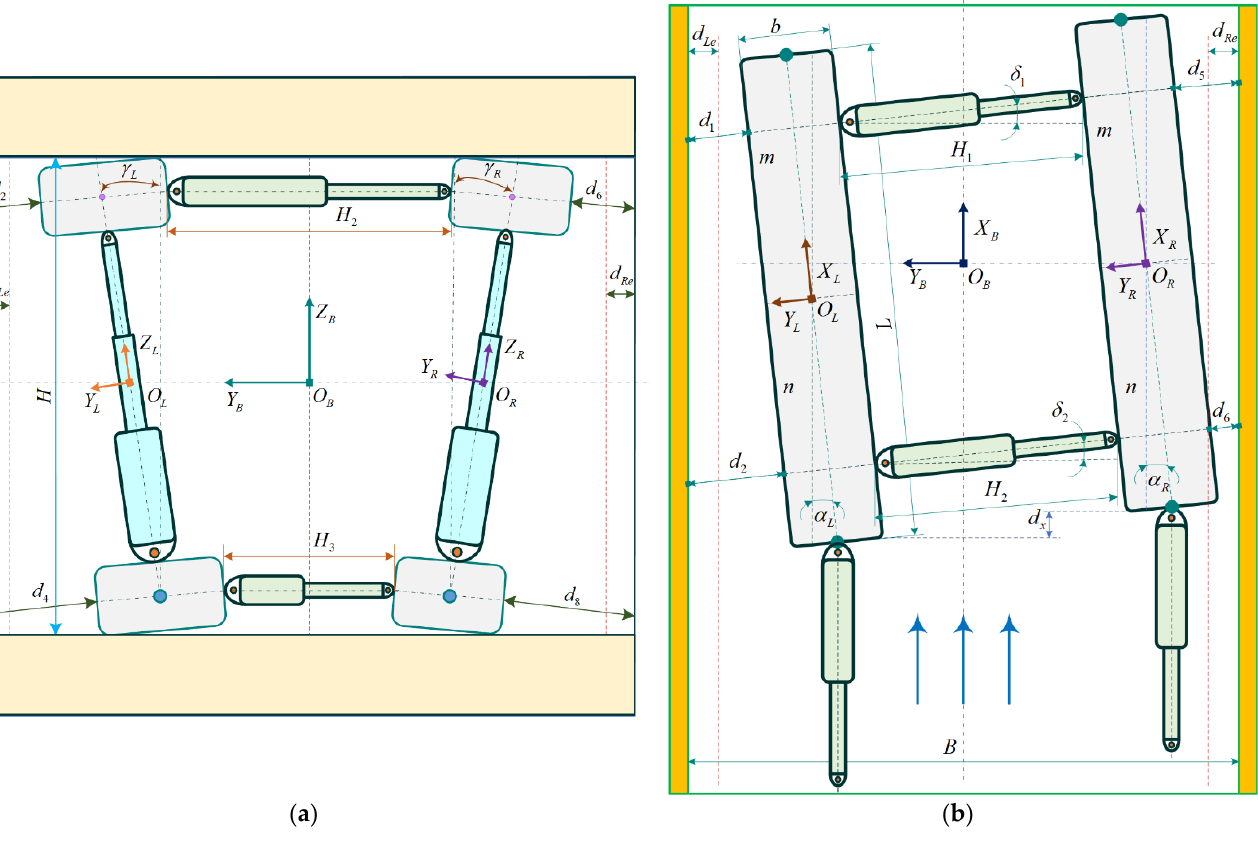
Figure 7. The kinematic model of ESR. ( a ) Main view of the model. ( b ) Top view of the model.